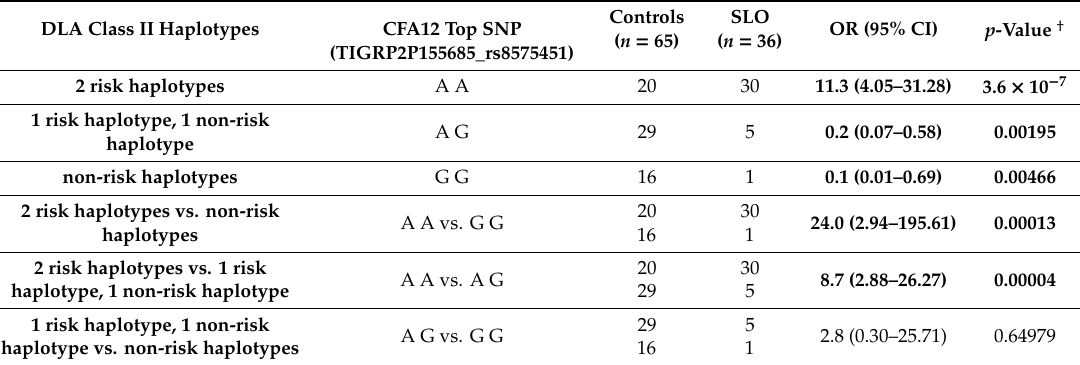
Table 1. Odds ratio (OR) for the top CFA12 SNP and corresponding number of DLA class II risk haplotypes in the 36 SLO and 65 healthy Bearded Collies. The bolded values were statistically significant at p <